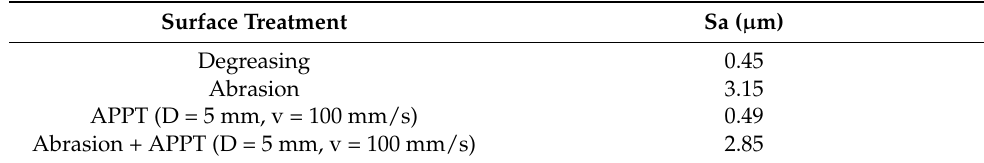
Table 3. Average surface roughness, Sa, for the considered pretreatments.